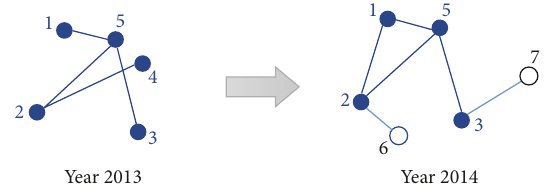
Figure 6: Illustration of the evolution of the coconsideration